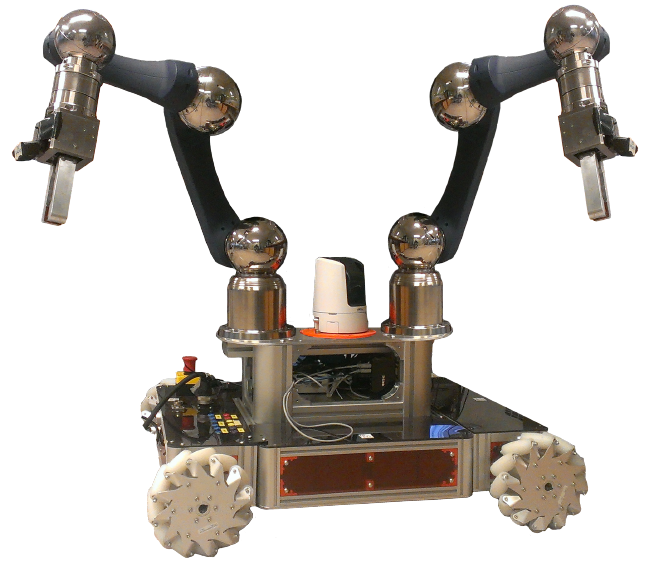
Figure 1. Dual-arm